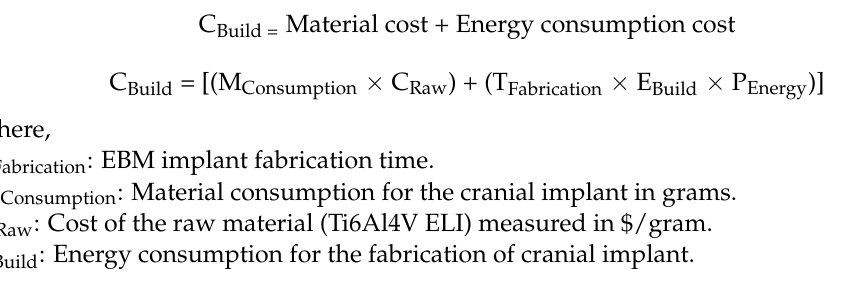
Figure 10. Chemical composition of Ti6Al4V powder used in the implant fabrication. Henceforth, an inclusive cost and time model developed by Priarone et al. [39] is adopted in this study to investigate the economics of EBM fabricated cranial implants (with supports and without supports). The main driving factors considered in this study are the material consumption, build time and the total cost involved in building the implants. The implemented cost model to estimate the building cost (C Build ) involves the material cost as well as the energy consumption cost as presented in Equation (1). As shown in Equation build whereas the energy consumption cost is associated with the cost of running the EBM machine while fabricating cranial implant. Other cost factors such as EBM ownership cost and EBM maintenance cost are not considered, as they remain constant for both cranial implants with and without